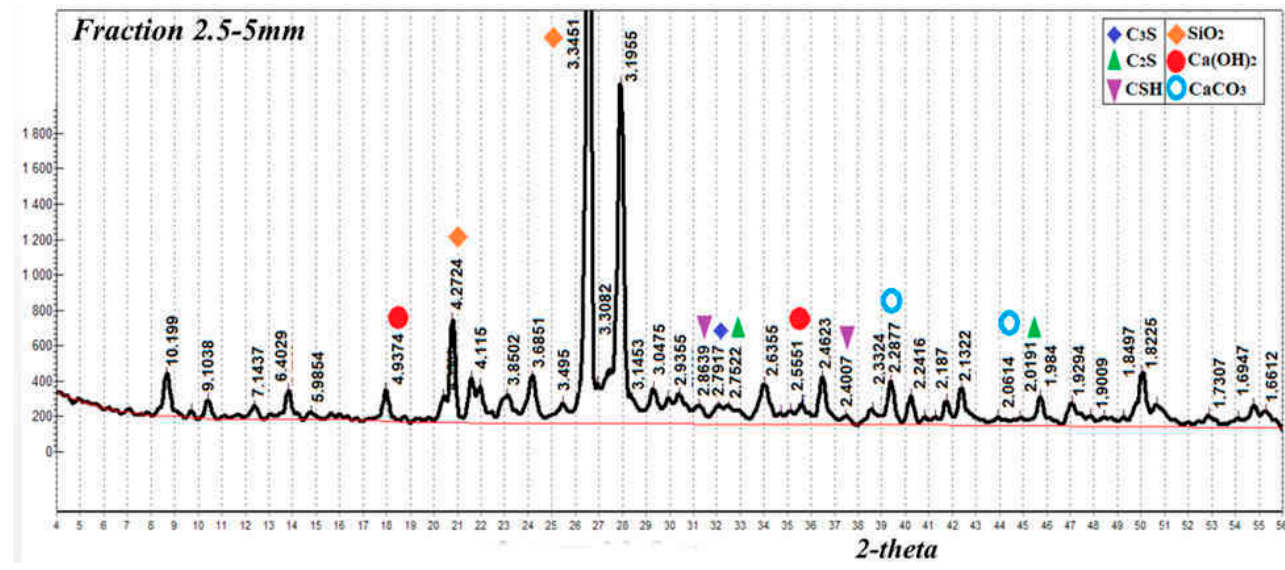
Figure 2. XRD patterns of screening fractions of the concrete scrap crushing. Different colored lines indicate the results for different fractions, and the red line at the bottom is drawn for ease of refer- ence.